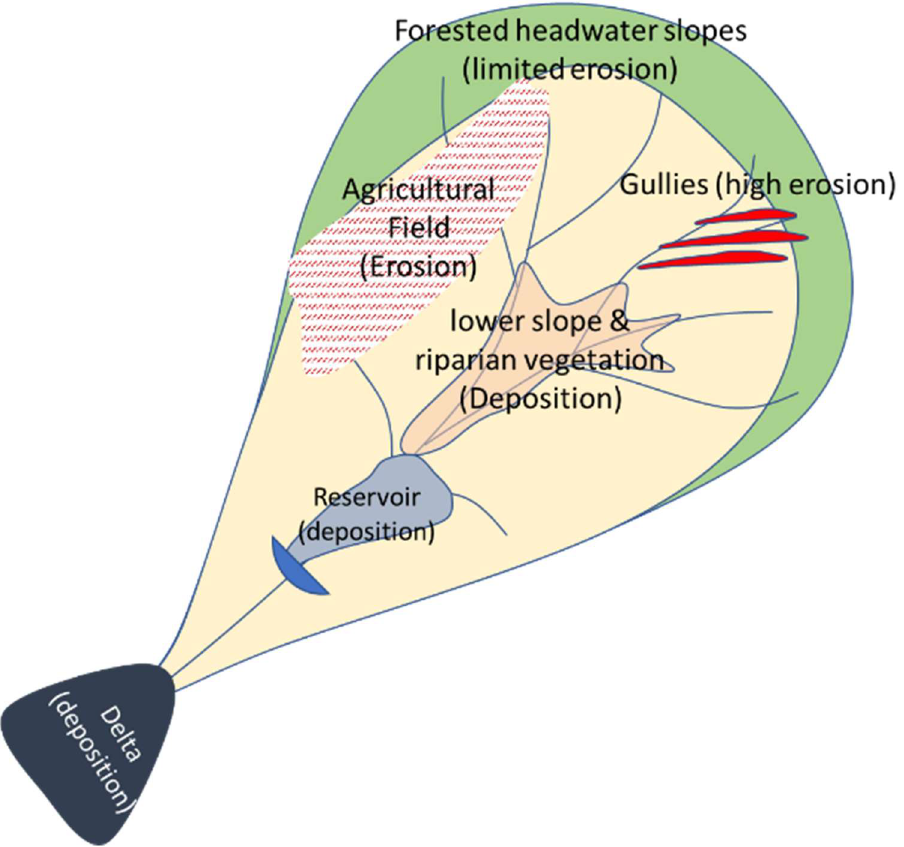
Figure 2. Illustration of sediment connectivity within a catchment.